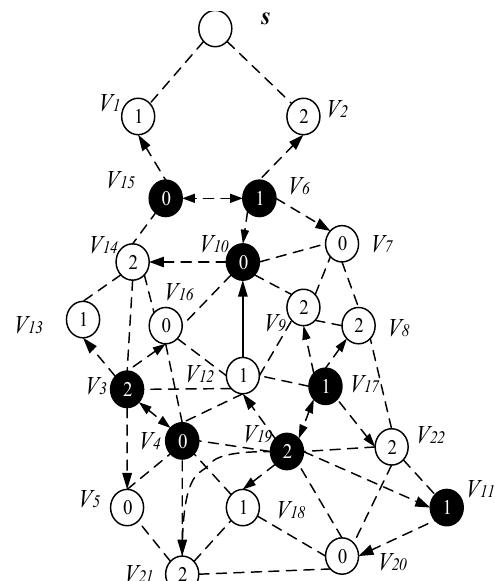
Figure 22. Minimum covering node set.